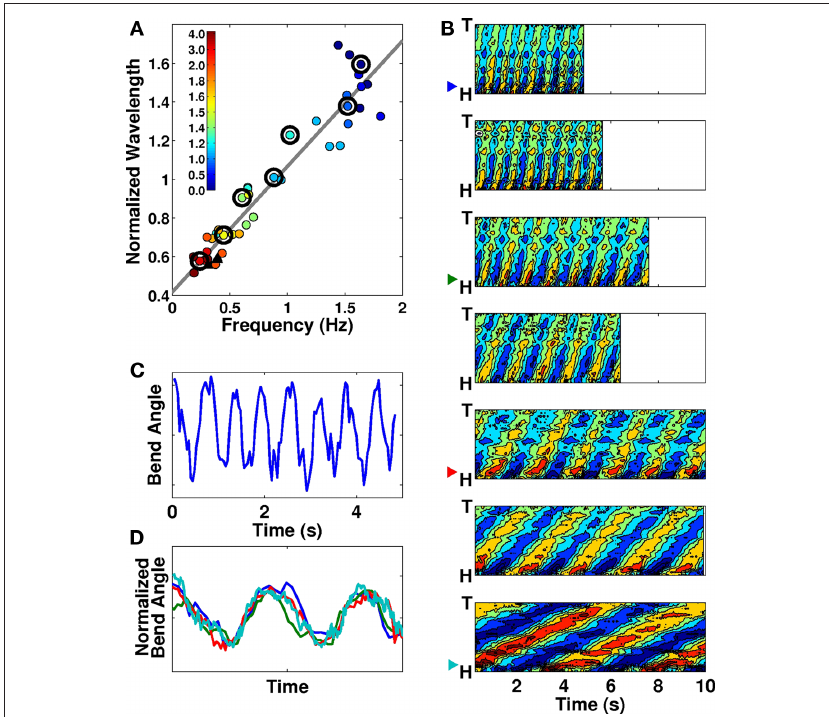
Figure 1 | (A) Frequency–wavelength relation across a range of gelatin concentrations (filled circles) and agar surfaces (black triangles). Colors represent gelatin concentrations (%) as indicated. The best linear fit to the data is superimposed. Adapted from Figure 1B in Berri et al. (2009). Large black circles indicate which contour plots are shown in (B) . (B) Seven contour plots of bending angle (represented by color, with dark red corresponding to extreme dorsal bending and dark blue to extreme ventral bending) over time (horizontal) and along the body (vertical), selected to show the range of observed forward locomotion behaviors, from “swimming” in liquid buffer solution (top) to “crawling” in relatively stiff gelatin (bottom; see methods in Berri et al., 2009 for additional details). Note the linear propagation along the entire body without changes in wave speed. (C) Trace of bending angle versus time for a point near the head of a worm in buffer solution [same data as top plot in (B) ]. Note that the worm does not dwell in the maximally bent positions (peaks and troughs of the curve). (D) Bending angle traces as in (C) , taken from the 1st, 3rd, 5th, and 7th panels of ( B ; see color-coded arrow heads) and normalized by undulation period and amplitude. Note the similarity of the